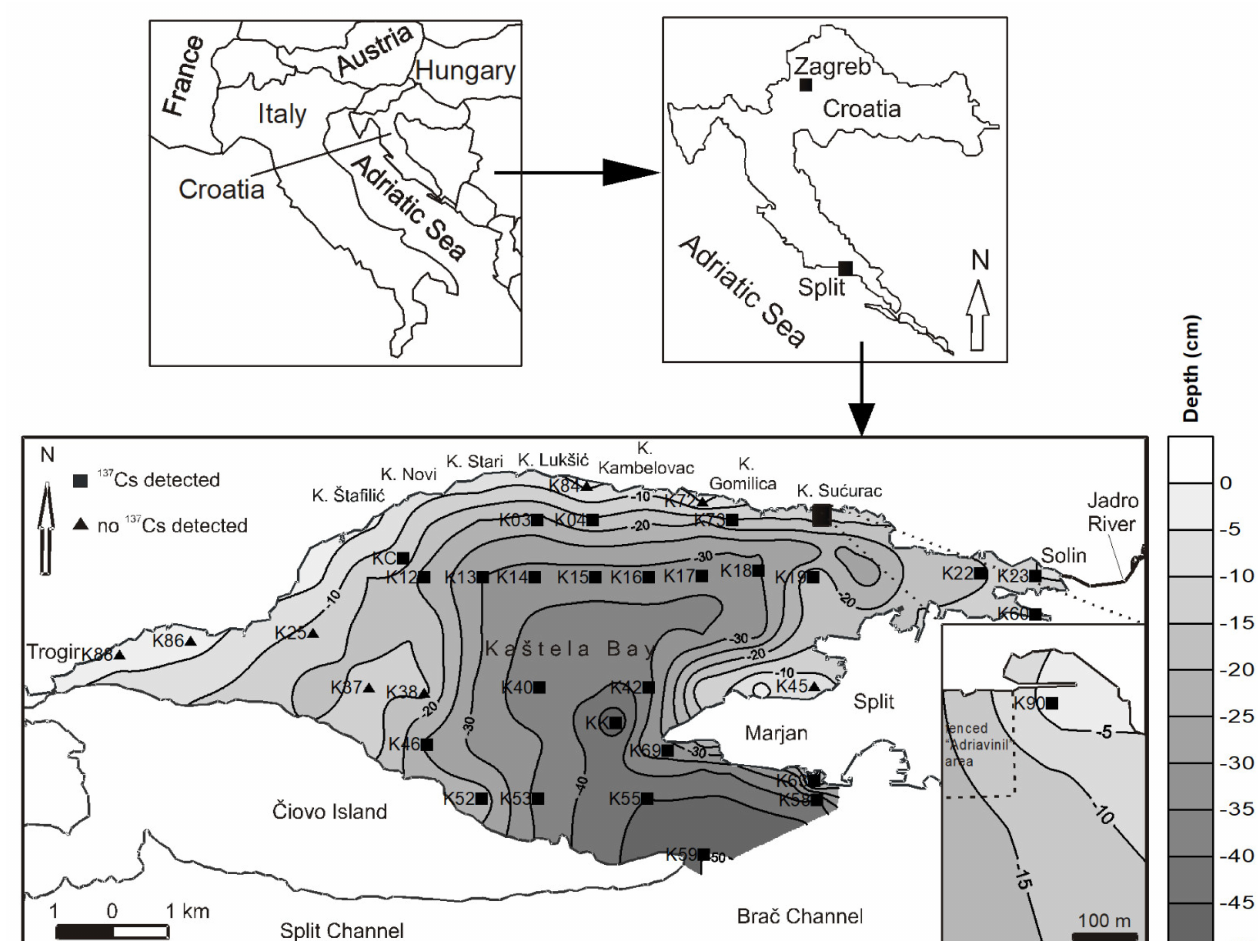
Figure 1. Location of the studied area and contour bathymetric map of Kaštela Bay with sampling stations representative of sedimentation processes. Squares denote cores with depth profiles of 137 Cs massic activities. Triangles denote cores with no 137 Cs detected at any sampled depth ( 137 Cs activities below minimum detectable